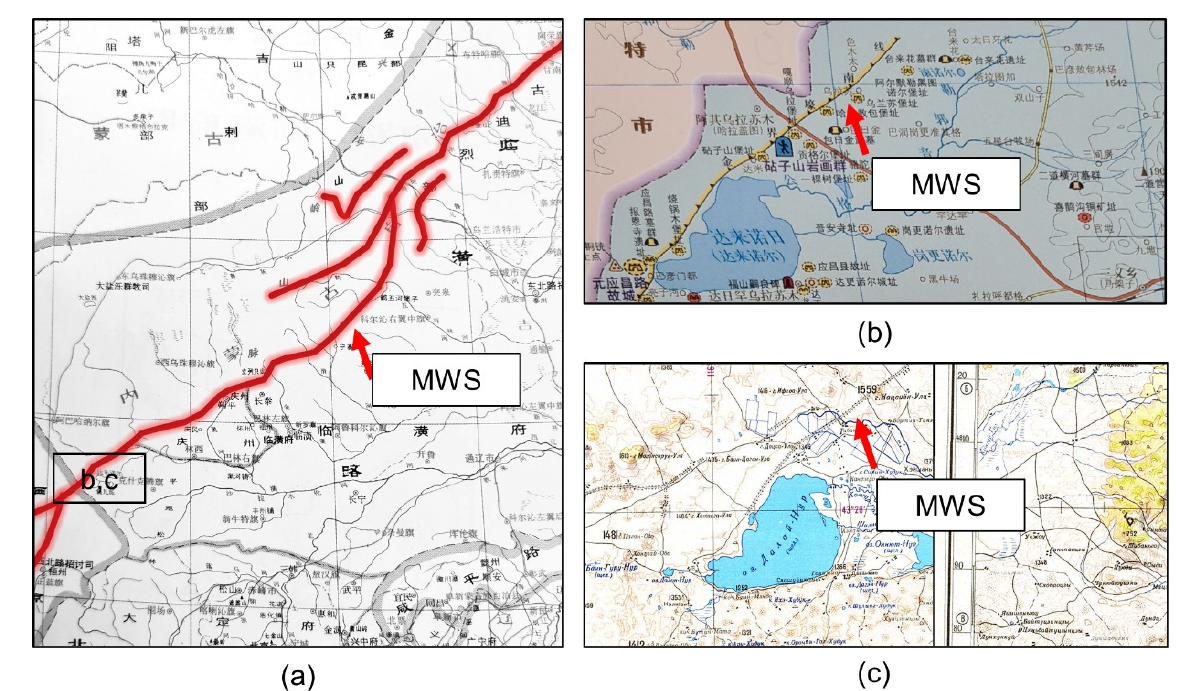
Figure 4. ( a ) Tan Qixiang’s Historical Atlas of China , ( b ) Atlas of Chinese Cultural Relics , and ( c ) The Soviet maps of the area.